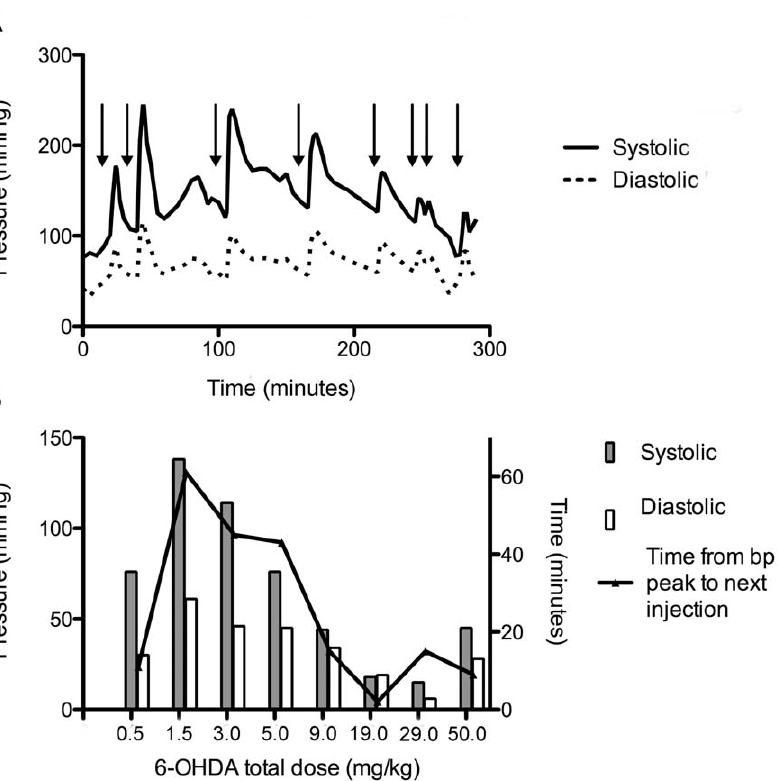
Figure 2. Systolic and diastolic blood pressure measurements during 6-OHDA administration. Blood pressure results from a representative animal (RH2318). A, Both pressures increase immediately after each 6-OHDA dosing (arrows). B, Change in systolic and diastolic blood pressure from peak of pressure following 6-OHDA until levels normalized at which time the next injection of 6-OHDA was administered. The amount of time to normalize paralleled the change in blood pressure. At the accumulated dose of 2.0 mg/kg, this animal required 61 minutes to regulate blood pressure. bp, blood pressure.